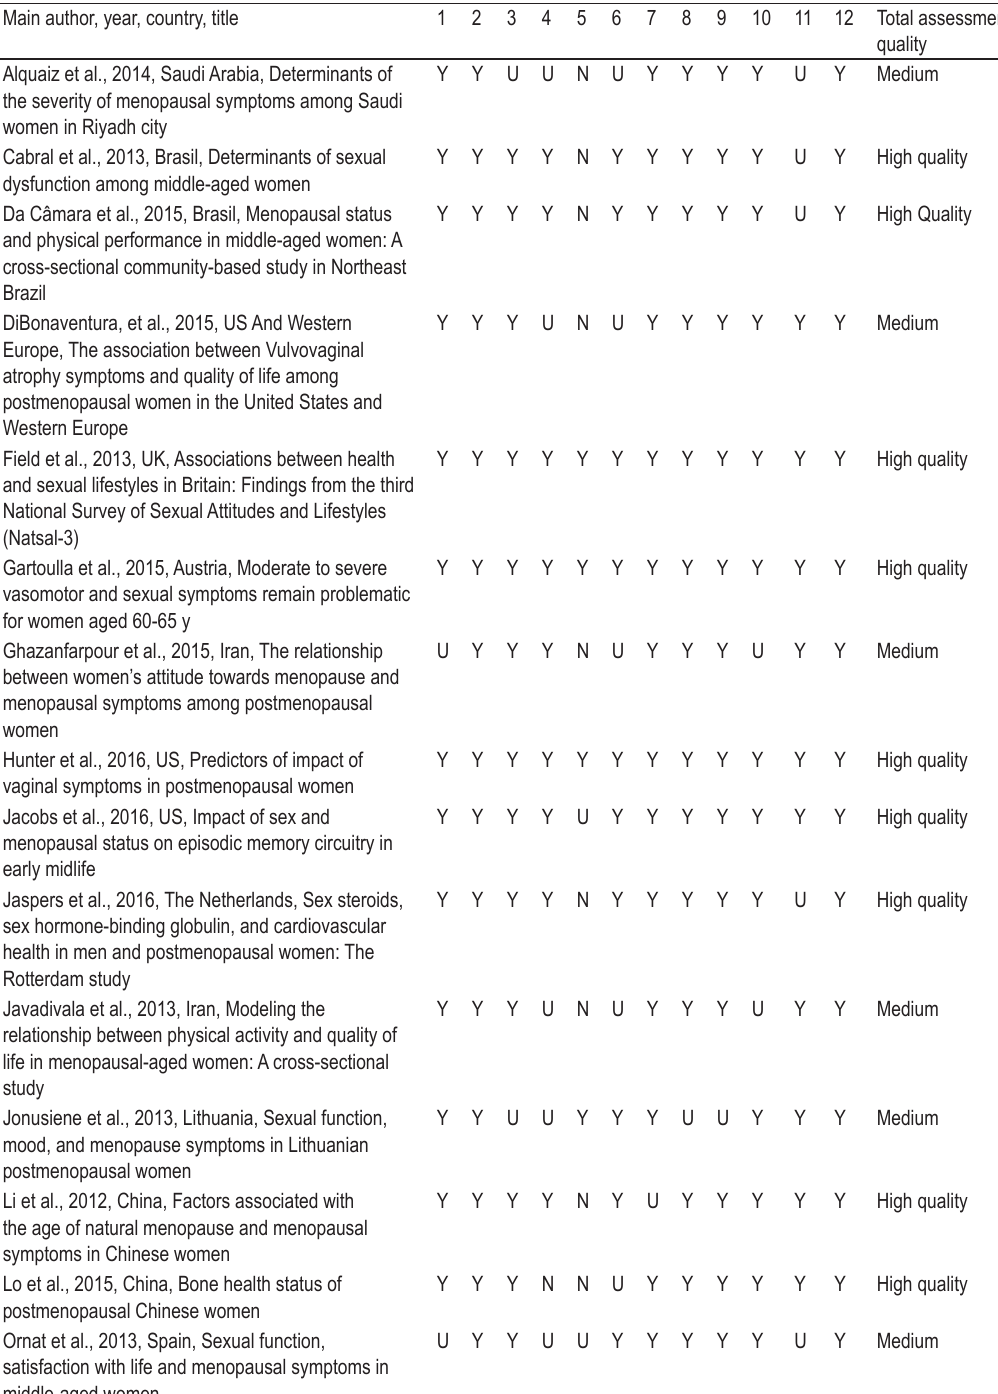
TABLE 2. Quality assessment of the included studies with a cross-sectional design